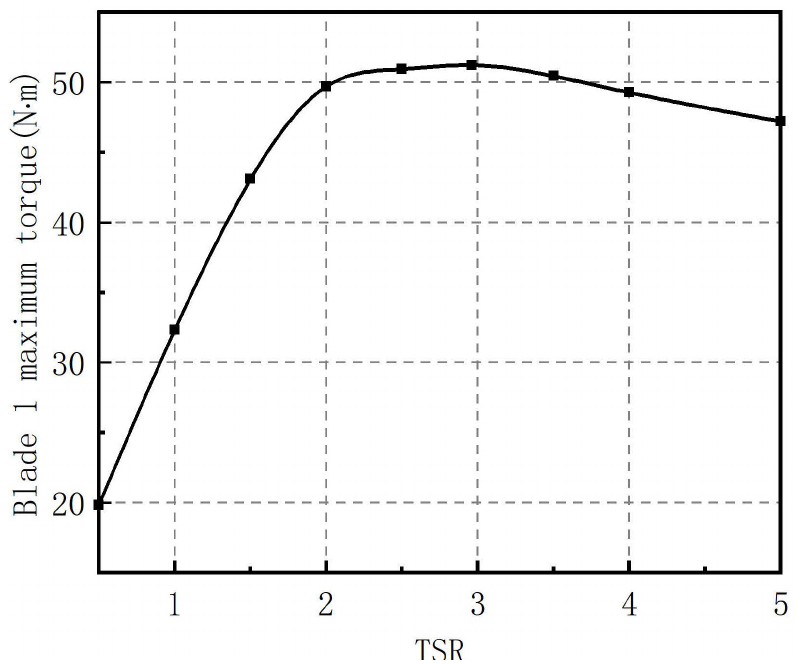
Figure 20. Curve of maximum torque changing with blade tip speed